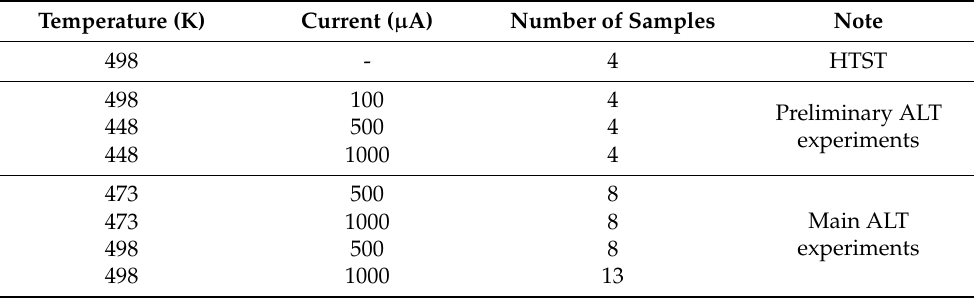
( b ) Figure 9. Monitored electrical characteristics of the ( a ) breakdown voltage (V BR ) and ( b ) dark current (I D ) at 473 K and 500 μ A. Based on the main ALT results, device failures were observed and cumulative failure analysis was performed using the log-normal distribution, and the mean time-to-failure (MTTF) of each testing condition was computed. Figures 10 and 11 illustrate the lognor- mal projection of the MTTF versus the percentage of cumulative failures for the thermal and electrical stresses in the main ALT experiment, respectively. From the figures, it can be observed that the results reasonably followed the normal distribution. In addition, it can also be observed that the electrical stress was more dominant than the thermal stress.